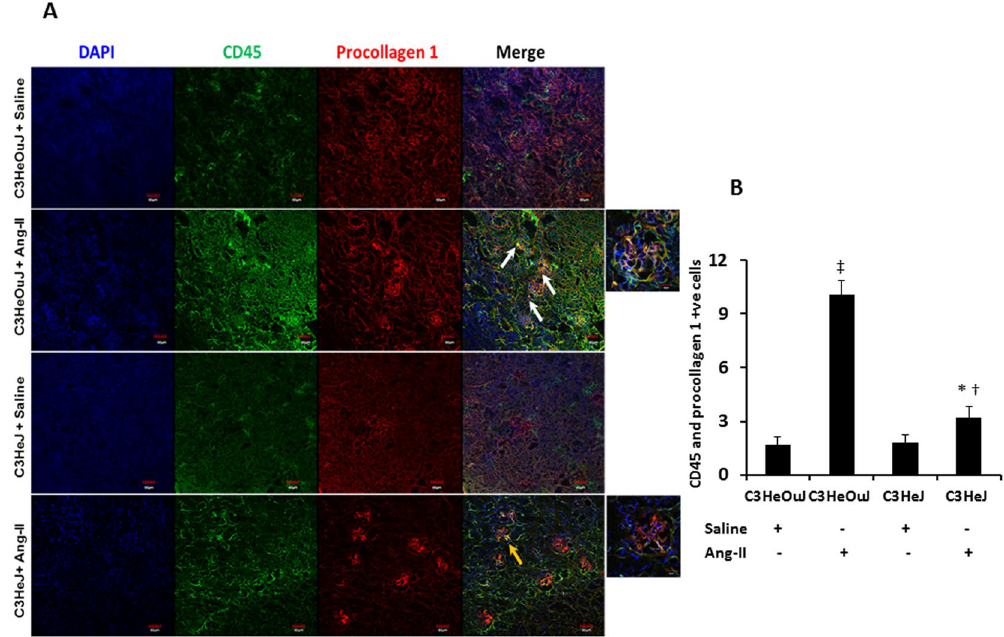
Figure 10. Infiltration of bone marrow derived fibroblasts is decreased in TLR4 deficiency mice following Ang-II treatment. ( A ) Representative images of kidneys stained for CD45 (green) and procollagen 1 (red) from C3H/HeOuJ and C3H/HeJ. C3HeOuJ mice treated with Ang-II show increased colocalization for both antigens (white arrows) compared to C3HeJ mice (yellow arrow). Outset images show yellow color in areas of colocalization. ( B ) Quantitative analysis of no. of cells positive for CD45 and procollagen 1. Data is presented as mean ± SEM. n = 5/group tested by Kruskal-Wallis test and Mann-Whitney rank sum test. Magnification × 20, Scale bar: 20 µ m. Outset image magnification × 100. Scale bar: 20 µ m. * p < 0.05 vs. C3HeJ + saline, † p < 0.05 vs.